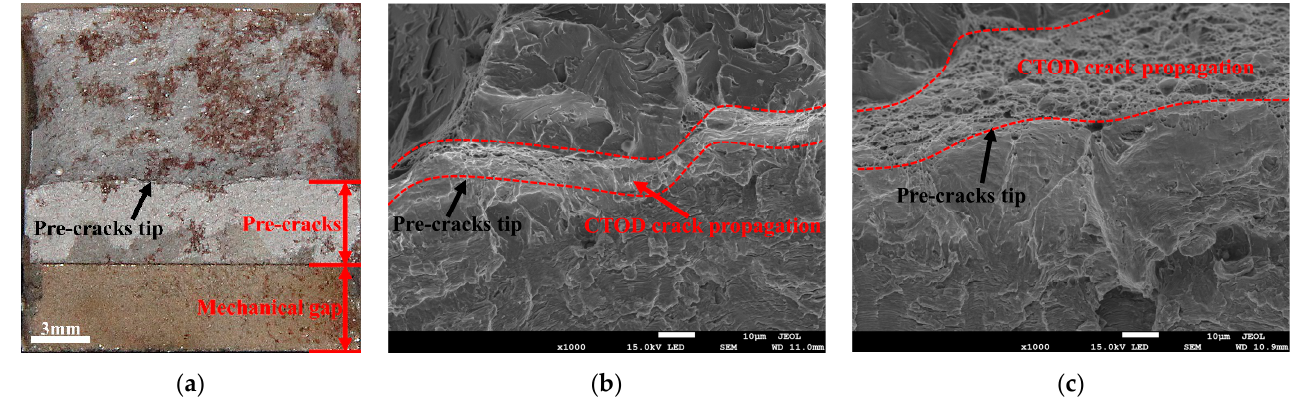
Figure 10. The fracture surface of the CTOD sample: ( a ) macroscopic; ( b ) brittle sample; and ( c ) non-brittle sample. brittle